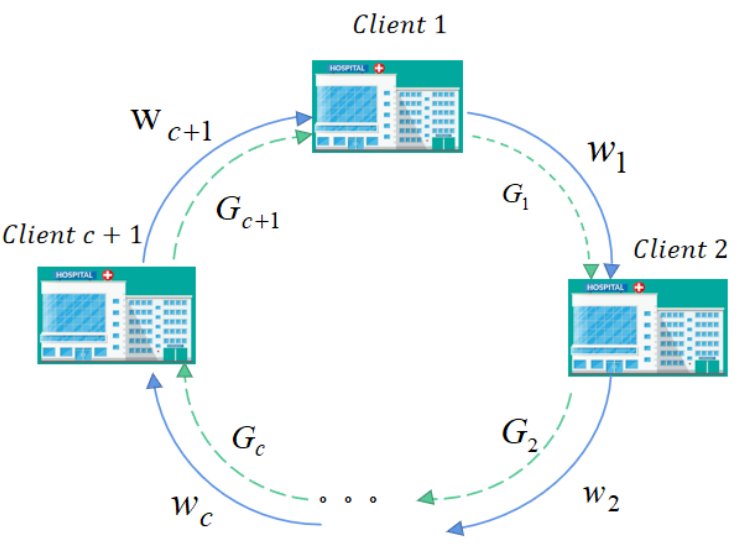
Figure 2. A schematic diagram of our cyclic federated learning method based on distribution information sharing and knowledge